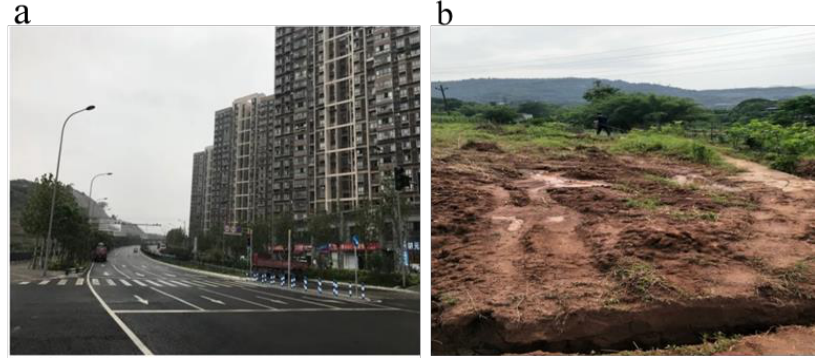
Figure 3. Roads in Jiansheng town. ( a ) The road in the town, ( b ) the road in the